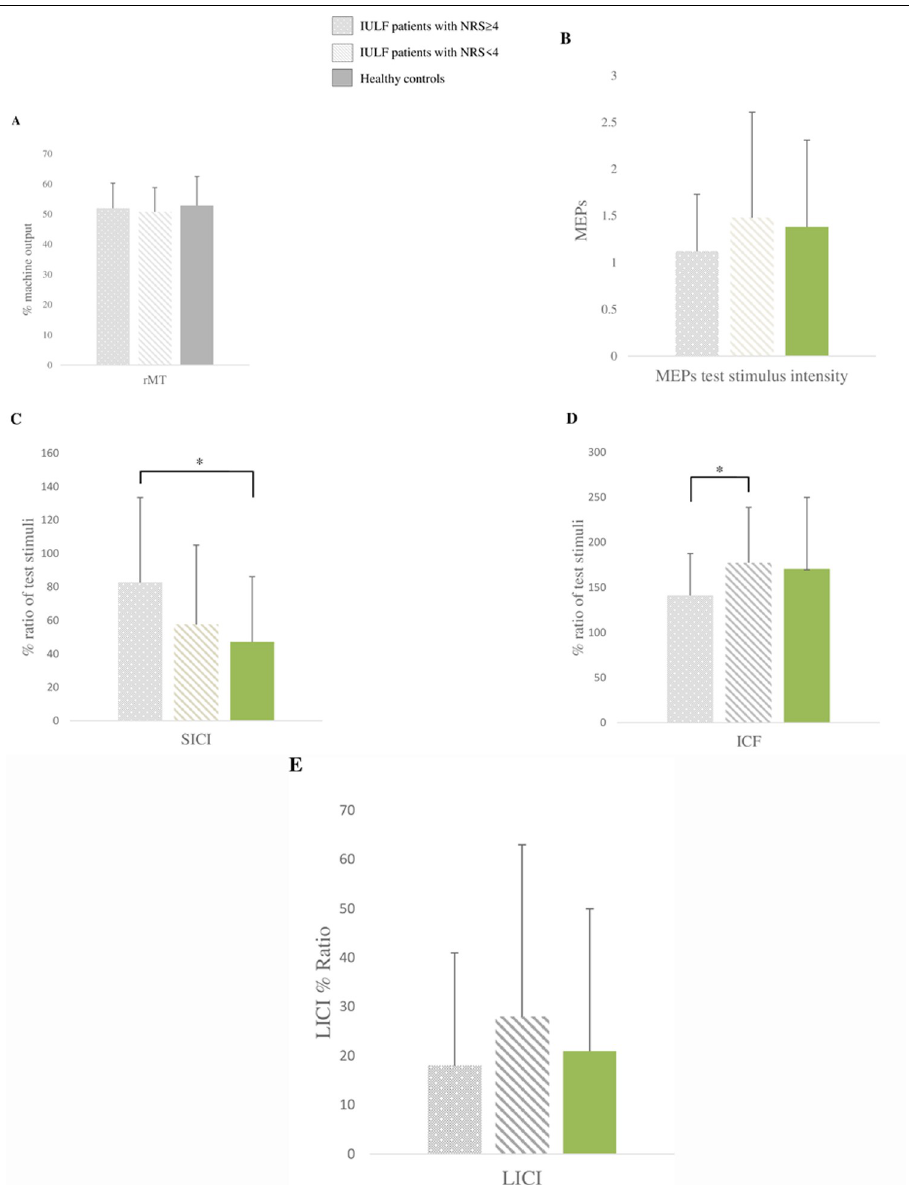
Fig 1. Groups differences on TMS measures. A. Between group comparison on rMT. B. Between group comparison on MEPs test stimulus intensity. C. Between group comparison on SICI. D. Between group comparison on ICF. E. Between group comparison on